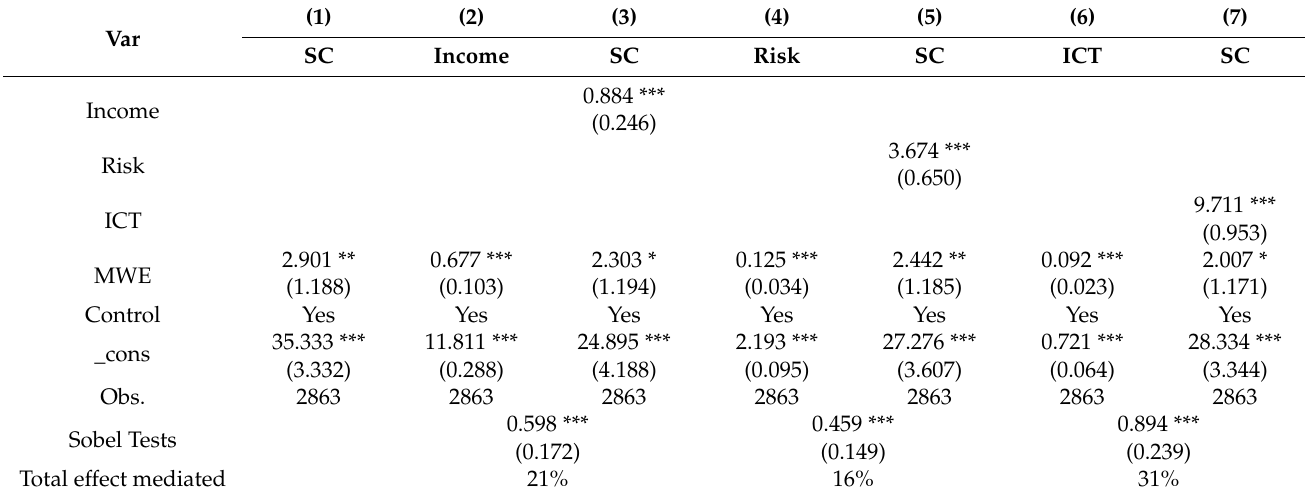
Table 4. Direct Effects and Mediating